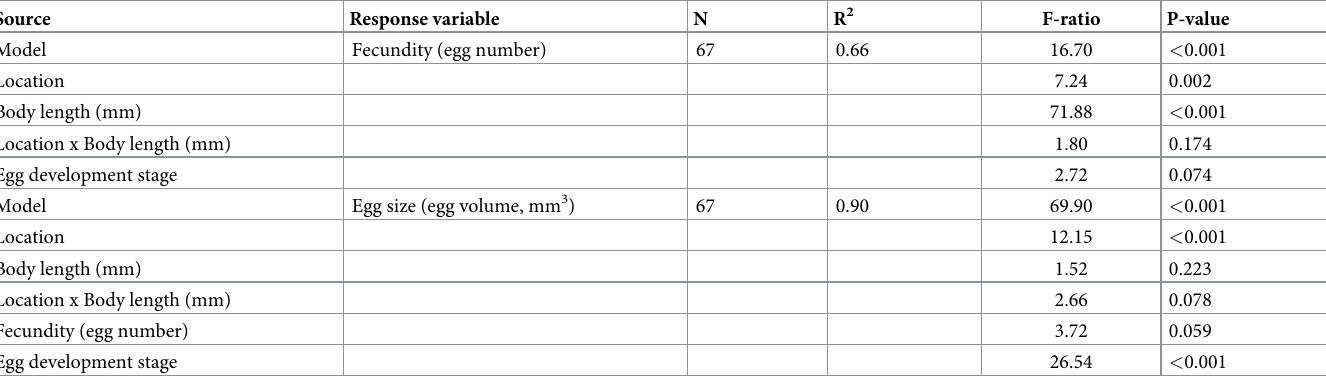
Table 3. Gonad investment in fecundity (i.e. number of eggs) and egg volume (mm 3 ).